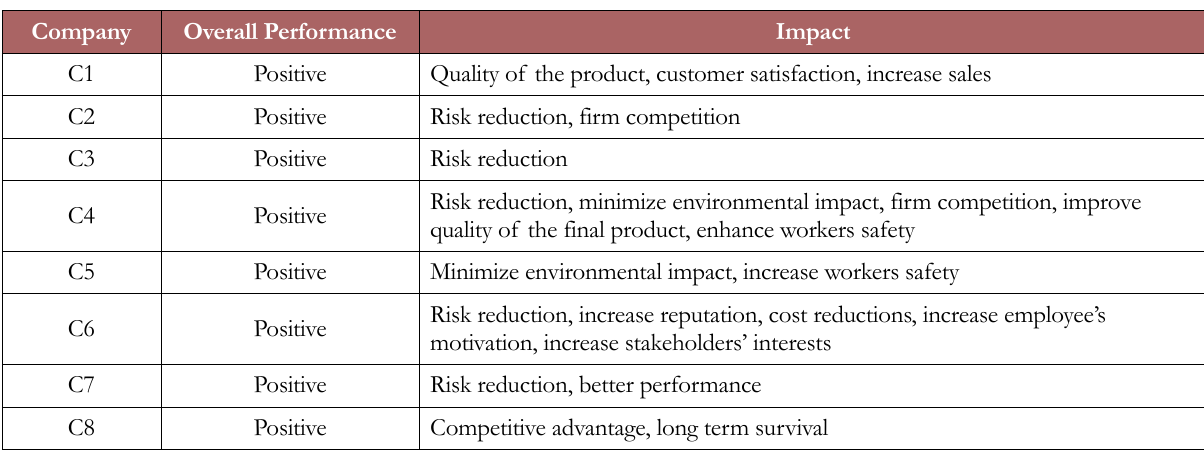
Table 3. Relationship between GPP and performance